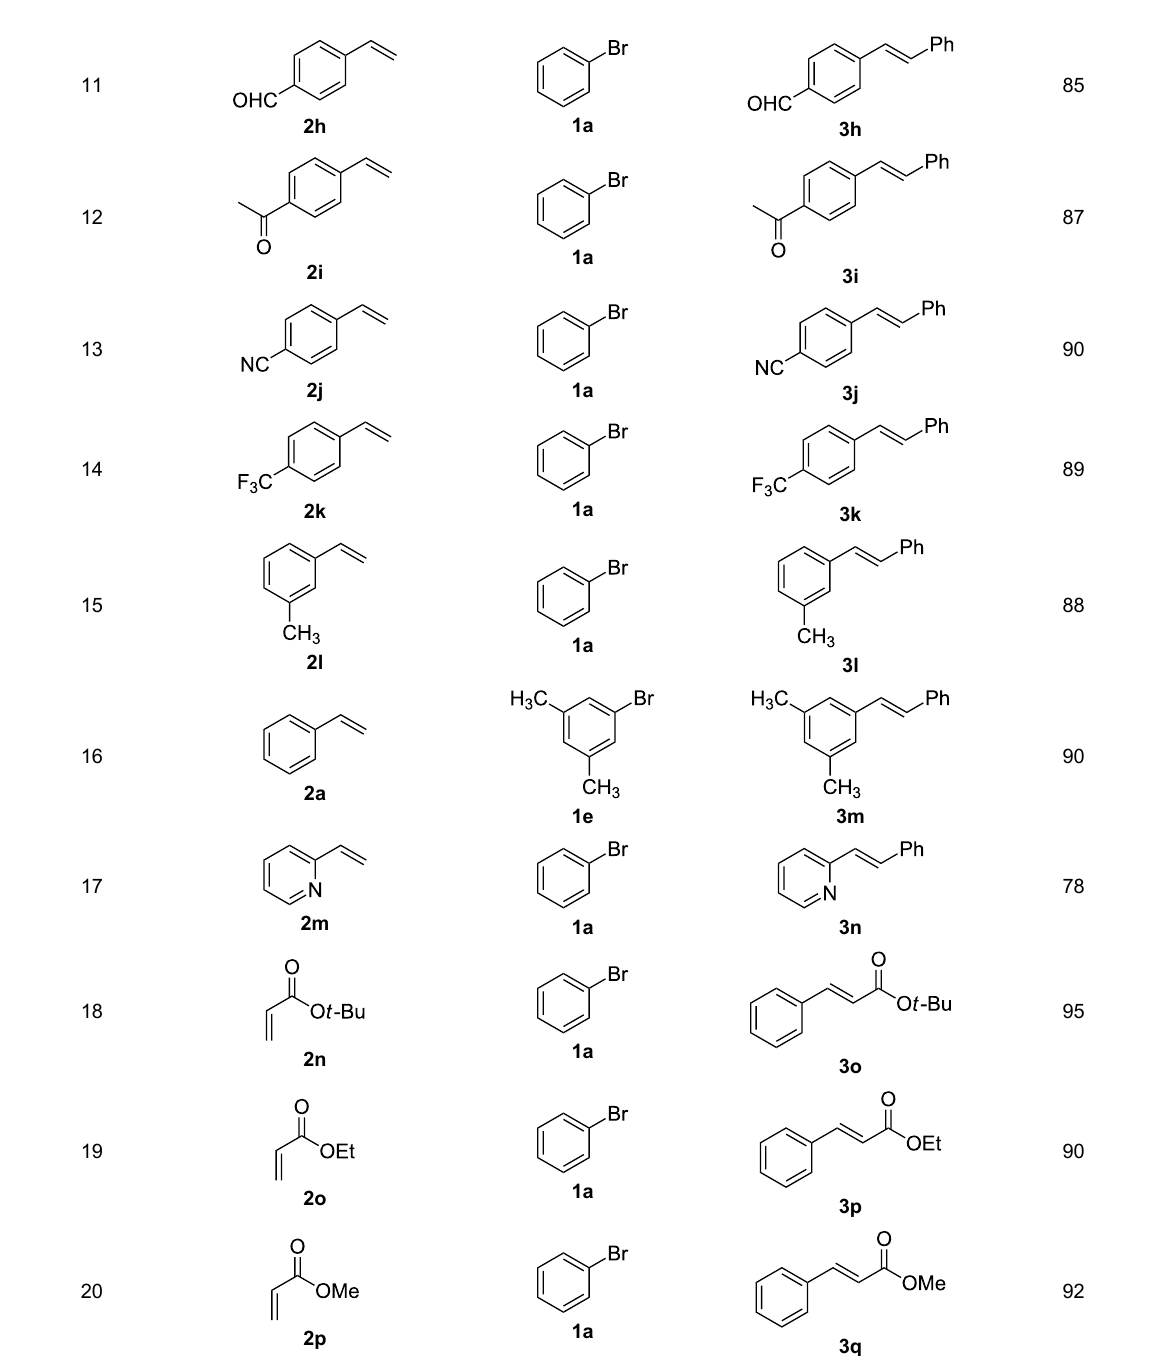
Table 2: Heck reaction of olefins and aryl halides: Scope of substrate. a